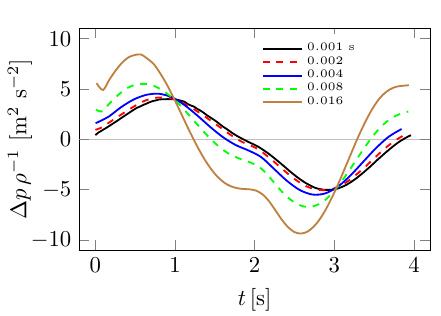
Figure 6. Influence of time step (cid:31) t on pressure drop (cid:31) p .